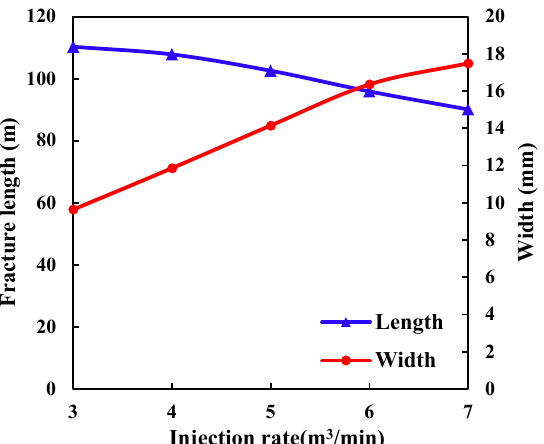
Figure 6. HF length and aperture curves under various flow rates after injecting for 30 min.